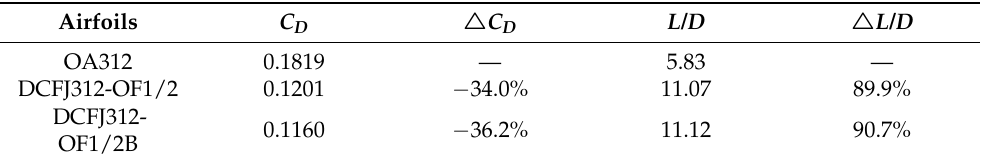
Table 13. Comparisons of drag coefficients and lift-to-drag ratios of DCFJ312 airfoils with various RUL s at AoA = 20 ◦ .